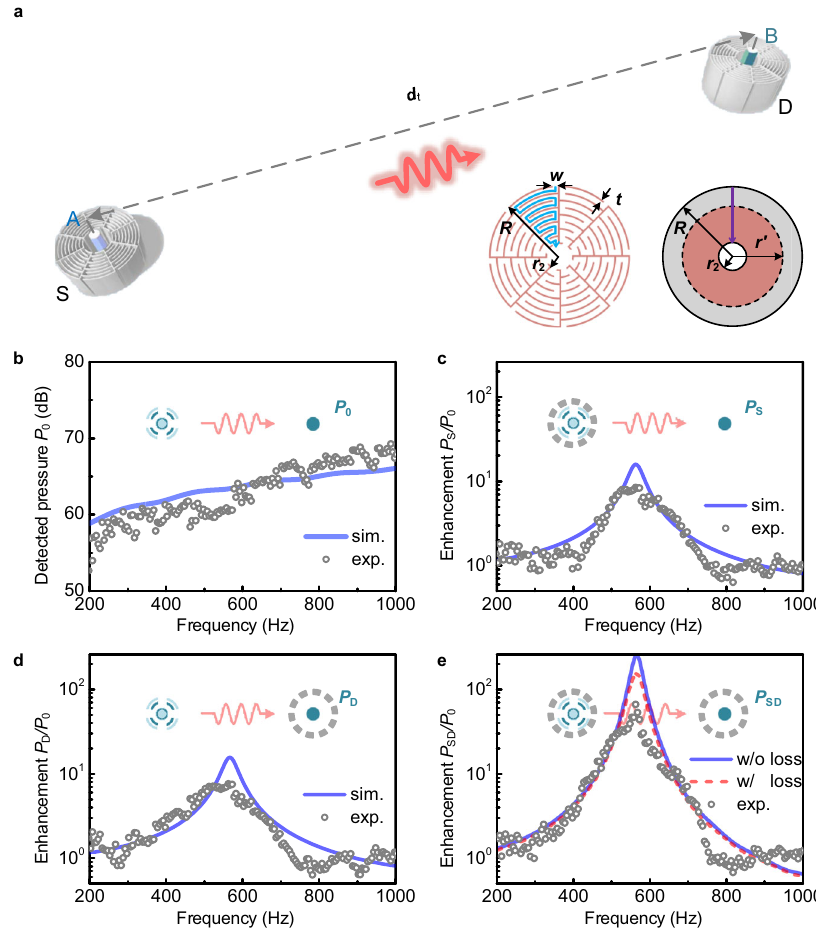
Fig. 3 Physical demonstration of the RWM system. a Schematic illustration. S and D refer to the source and detector meta-cavities, respectively. The amplitude of source A is adjusted to ensure that the direct radiative transfer from A to B is negligible. Inset: schematic cross-sectional view of the meta- cavity (left) and its equivalent physical model (right). b Detected pressure P 0 for direct transfer from A to B without meta-cavities S and D [refer to Fig. 1a, b]. Detected pressure enhancement from A to B for c P S / P 0 with S only, d P D / P 0 with D only, and e P SD / P 0 with both S and D [refer to Fig. 1c]. Here the transfer distance d t is 32.5 times the radius of the